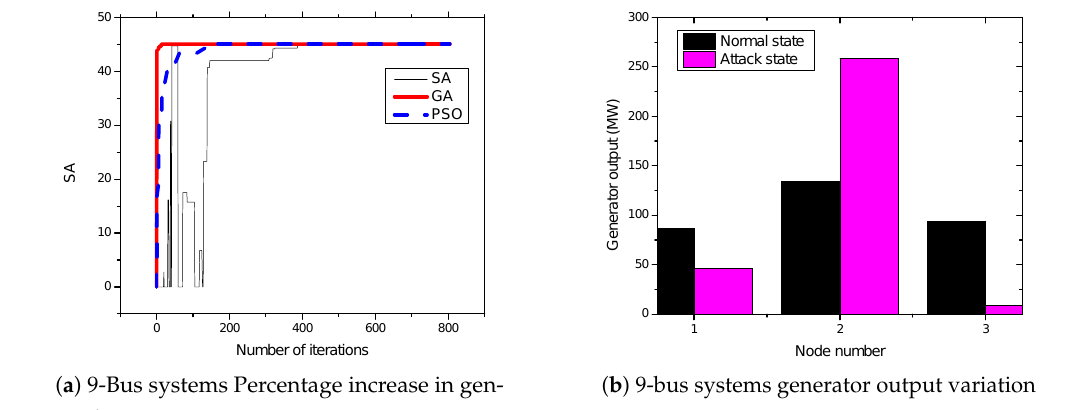
Figure 6. 9-bus systems increase in generation cost and generator output variation.